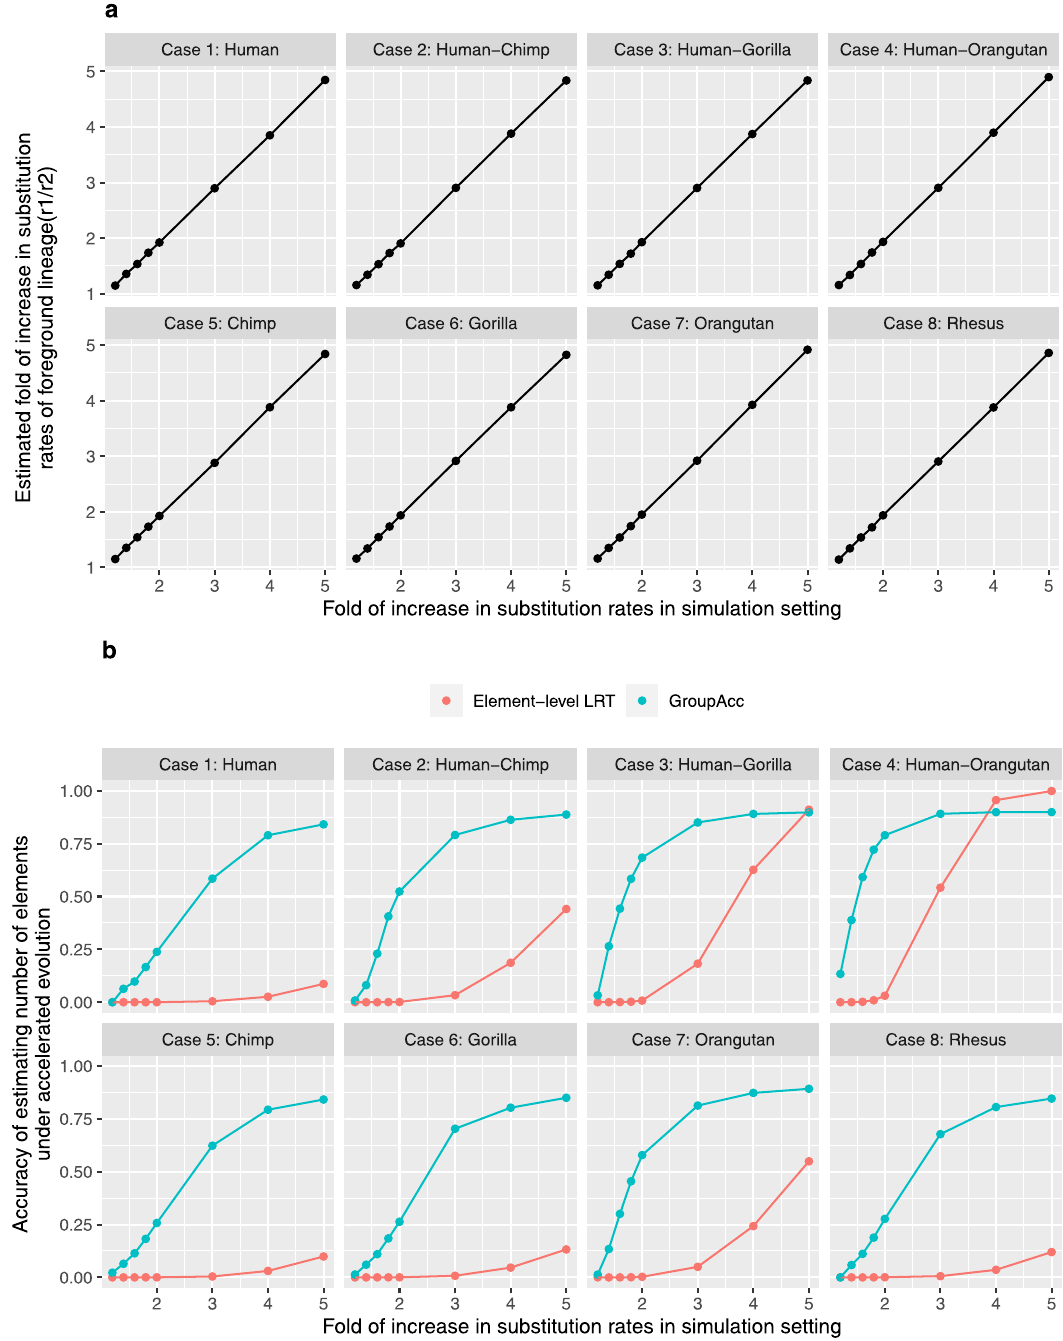
Fig. 2 | Simulation results of scenario 1 with foreground lineage matching the accelerated lineage in each case (1 – 8). a X -axis shows the scaling factor of fore- groundlineagebranchlengthinsimulationsetting,whichistherealfoldofincrease in the substitution rate of theforeground lineage. Y -axisshowsthe fold of increase